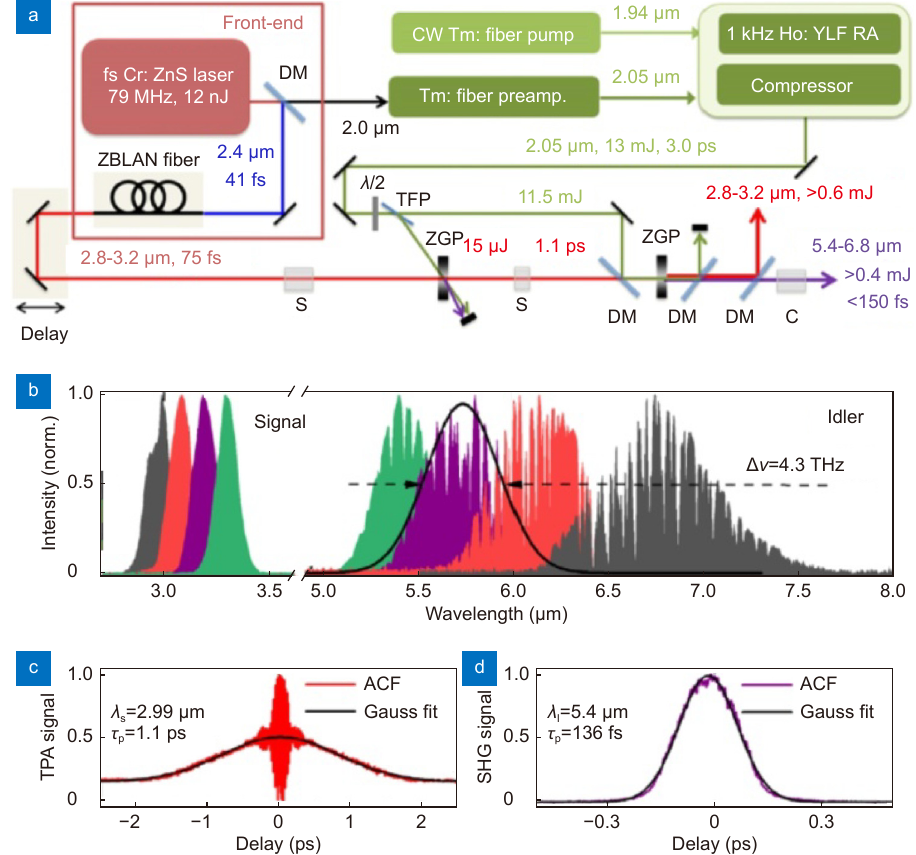
Fig. 9 | ( a ) Setup of the MIR OPCPA that comprises the front-end including femtosecond Cr:ZnS master oscillator and fluoride fiber (ZBLAN), Ho:YLF regenerative amplifier as pump and two optical parametric amplification stages based on ZGP crystals. ( b ) Spectral intensities of the sig- nal (left) and the corresponding idler pulses (right). Autocorrelation functions (ACF) of ( c ) uncompressed signal at 2.99 μm and ( d ) re-com- pressed idler pulses at 5.4 μm. Figure reproduced with permission from ref. 182 , The Optical